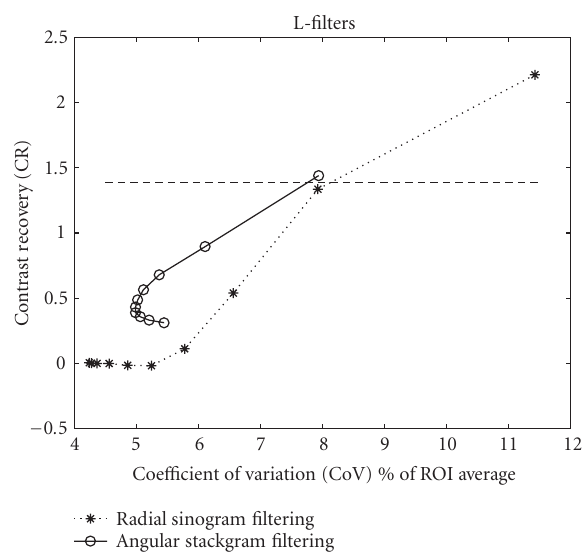
Figure 5: Resolution-noise tradeo ff curves for the compared meth- ods with the L-filters. The points of the curves represent the ker- nel widths of the 10 nonlinear filters. The lines simply connect the points. The kernel width gets wider (i.e., the filtering strength in- creases) from top-right to bottom. Angular stackgram filtering pro- vides a better tradeo ff than radial sinogram filtering for all the filter kernels. The chosen or matched resolution level is also shown.